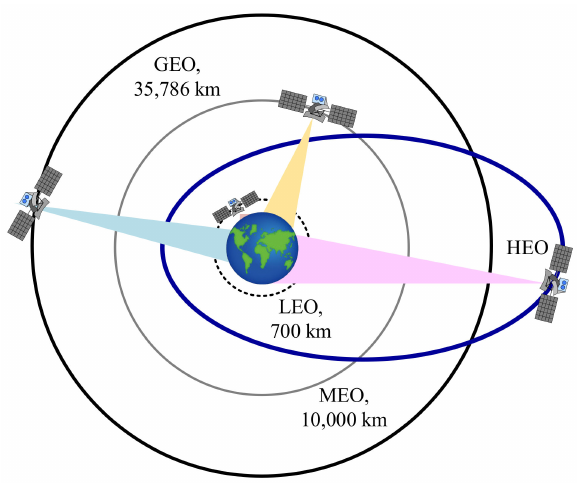
Figure 1. Satellite geometric configuration observation in different